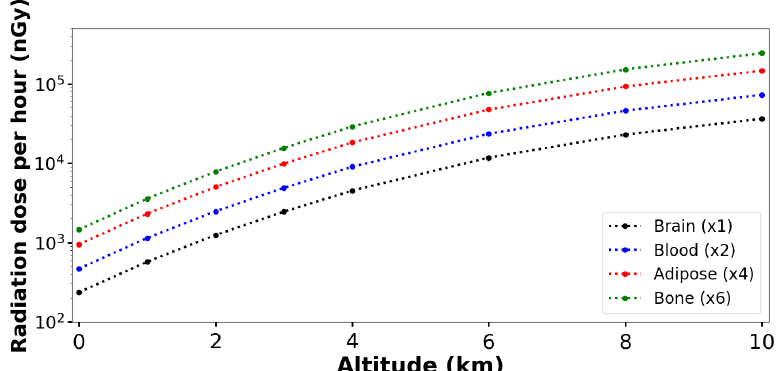
Figure 4. Radiation dose deposited in blood, adipose, brain and bone tissue samples by atmospheric neutrons with energies between 1 and 1000 MeV, as a function of the altitude for a latitude of 0 ◦ and a longitude of 0 ◦ . This result was obtained by a numerical simulation, the RD was calculated for a period of one hour in spherical samples with a radius of 5 cm. See text for more detail.